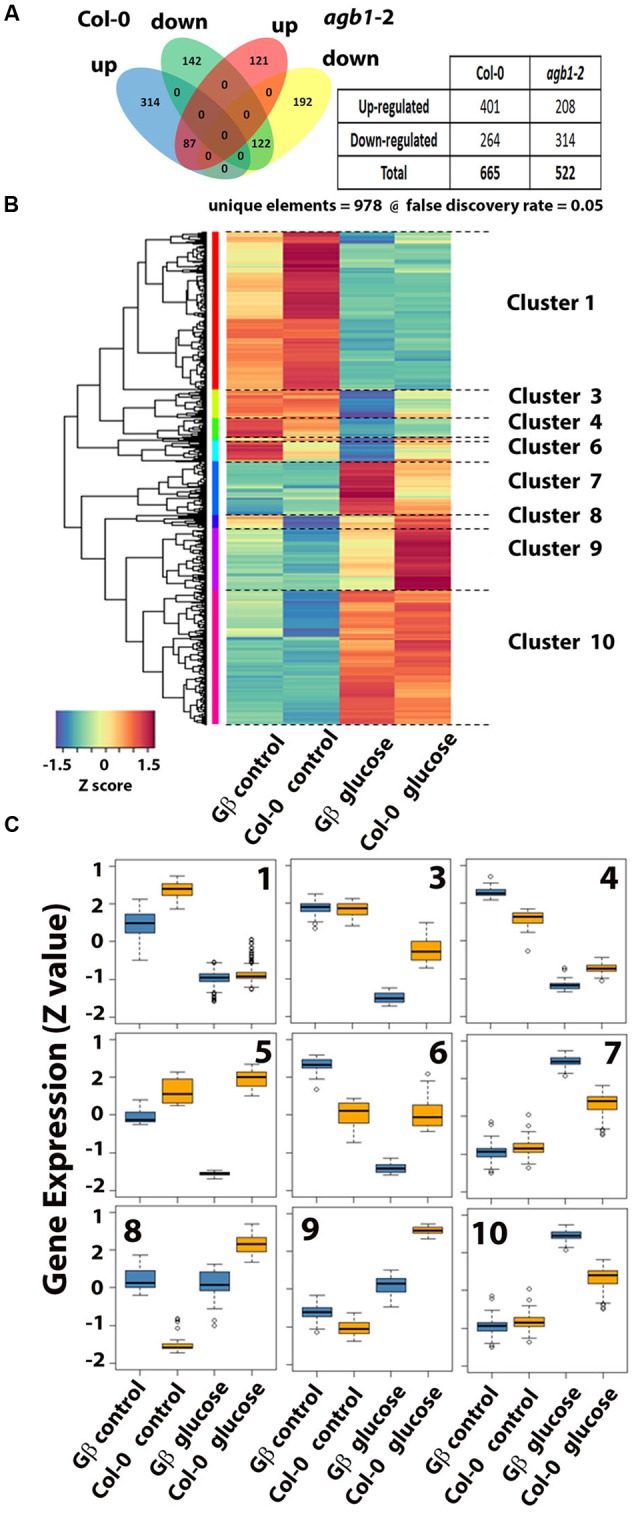
Glucose-induced gene expression in the 1-mm root tips of wild type and agb1-2 mutant. Five-day old, etiolated seedlings were treated with glucose for 4 h and the apical 1-mm of roots was harvested for RNA profiling as described in Materials and Methods. (A) Venn diagram quantitating genes that were differentially expressed in the two genotypes. The table inset summarizes the number of genes scored as up or down regulated in each genotype. (B) Cluster analysis of the genes that have altered expression displayed as a heat map. Ten distinct clusters were formed. Clusters 2 and 5 had too few genes to label. (C) The expression profile of each cluster is shown as a box plot. The top of the rectangle indicates the third quartile, the horizontal line indicates the median, and the bottom of the rectangle indicates the first quartile. The vertical line from the top indicates the maximum value, and the other vertical line extending from the bottom indicates the minimum value.